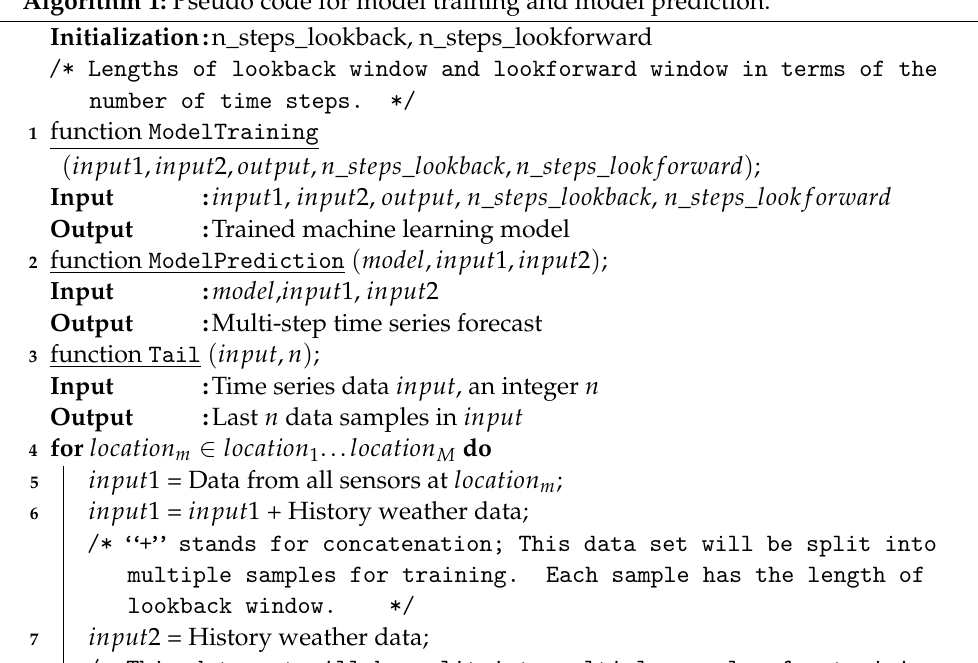
Algorithm 1: Pseudo code for model training and model